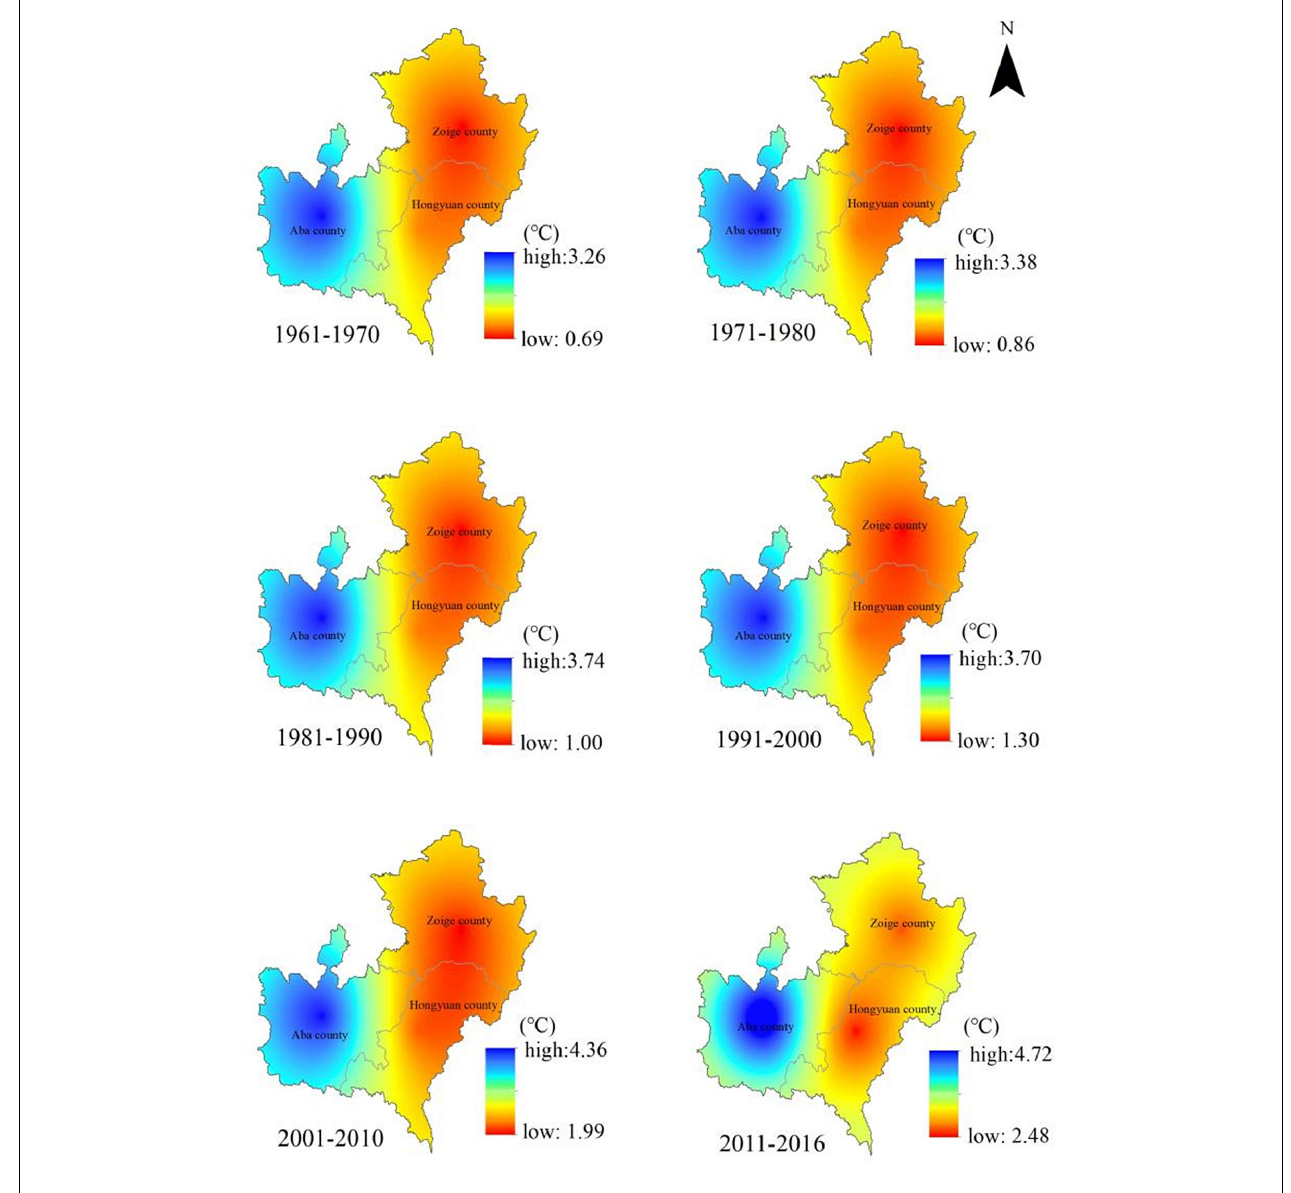
FIGURE 5 | Average annual temperature from 1961 to